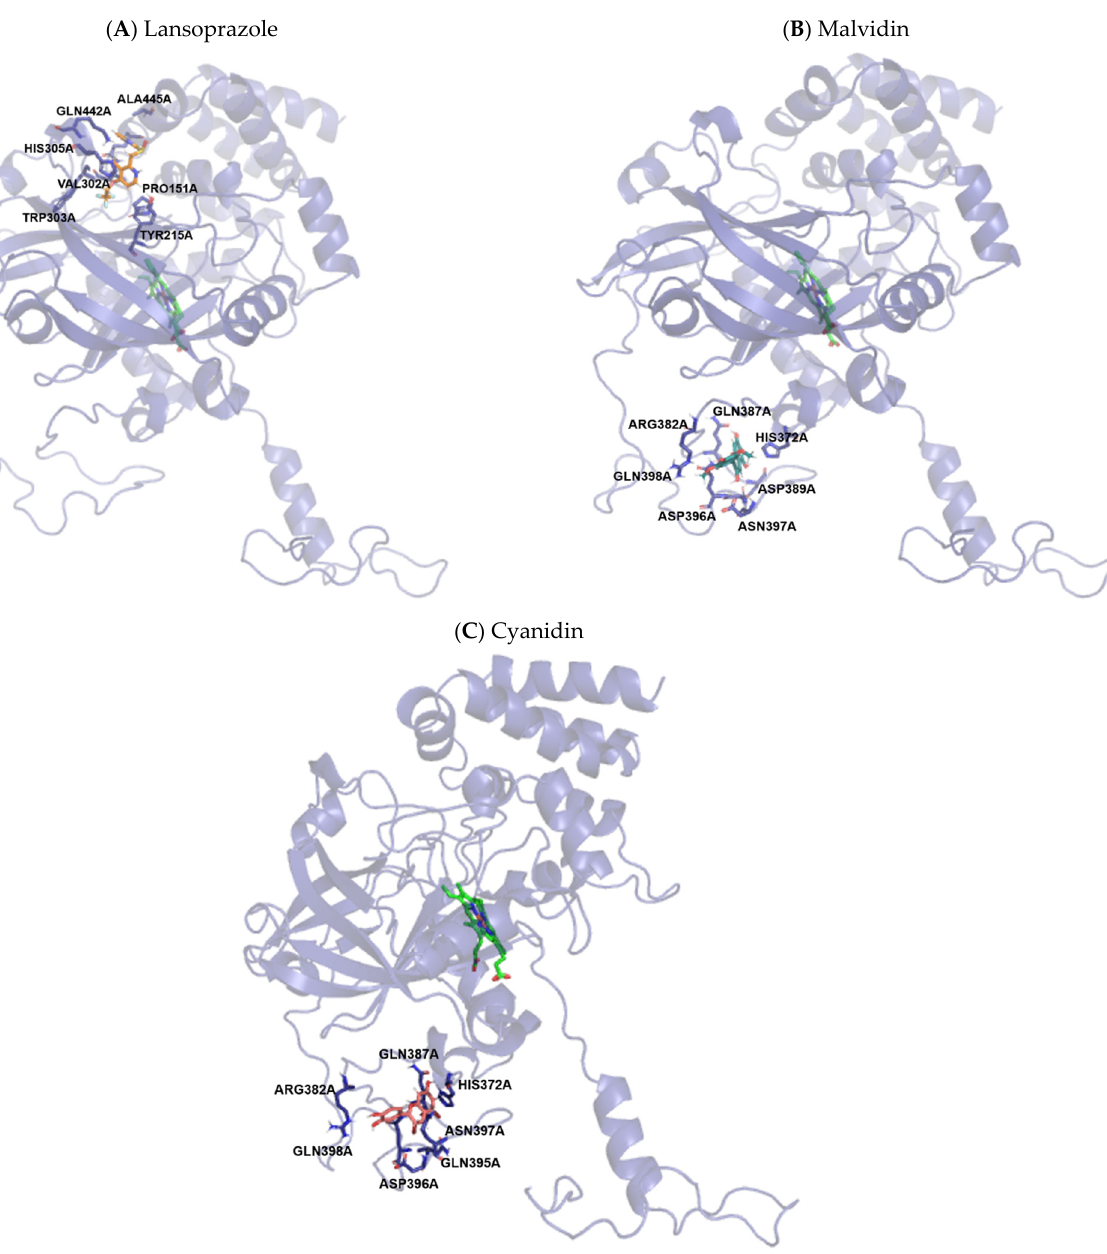
Figure 12. Molecular coupling of the lansoprazole ( A ), malvidin ( B ) and cyanidin ( C ) molecules in the Catalase (CAT) protein structure–PDB 1F4J, docking in chain A. ( A ) Lansoprazole : Best pose with − 7.7 kcal/mol (affinity energy). Heme group shown colored in green. Lansoprazole molecule colored in orange. ( B ) Malvidin : Best pose with − 7.6 kcal/mol (affinity energy). Heme group shown colored in green. Malvidin molecule colored in bluish-green. ( C ) Cyanidin: Best pose with − 7.9 kcal/mol (affinity energy). Heme group shown colored in green. Cyanidin molecule colored in pink.